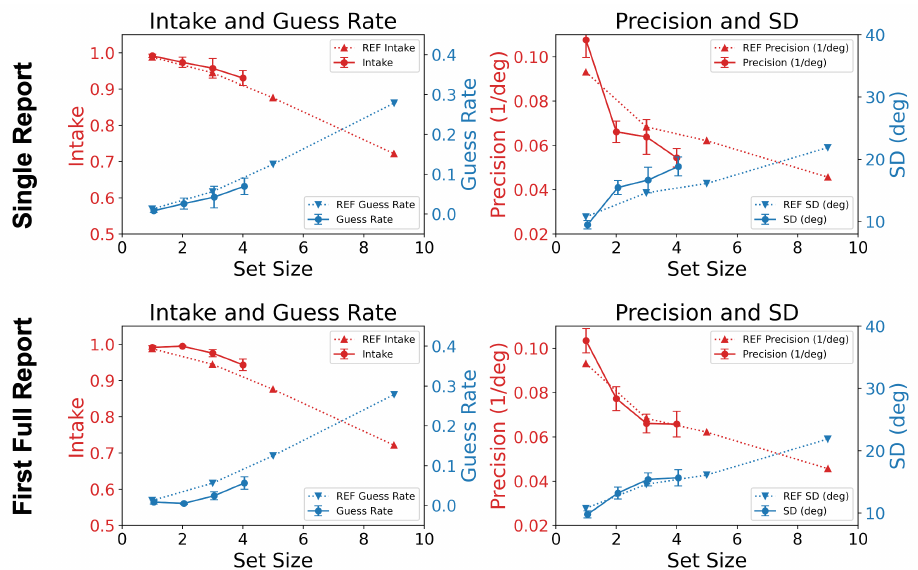
Figure 5. Intake ( left column ) and precision ( right column ) as a function of set size. Error bars represent ±SEM. The plots also include the guess rate (1 − ω ) and SD ( σ ) on the right vertical axes. The solid curves show the results from the data analyzed in the current paper, whereas the dotted curves were replotted from Ö˘gmen et al. [21], abbreviated as REF in the inset of the figure for comparison. Overall, there was good agreement between the results obtained from the two different